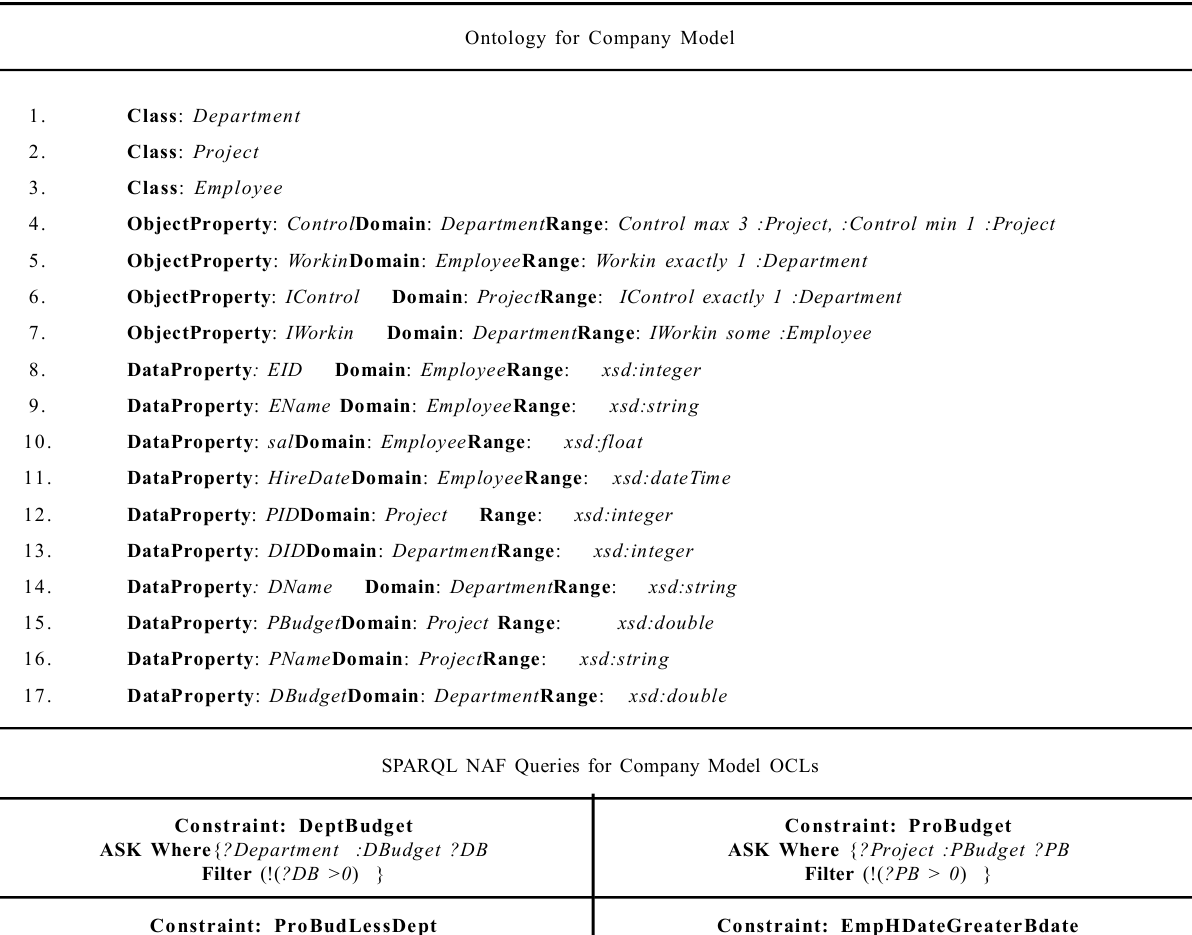
TABLE 7. COMPLETE ONTOLOGY-BASED TRANSLATION OF COMPANY MODEL